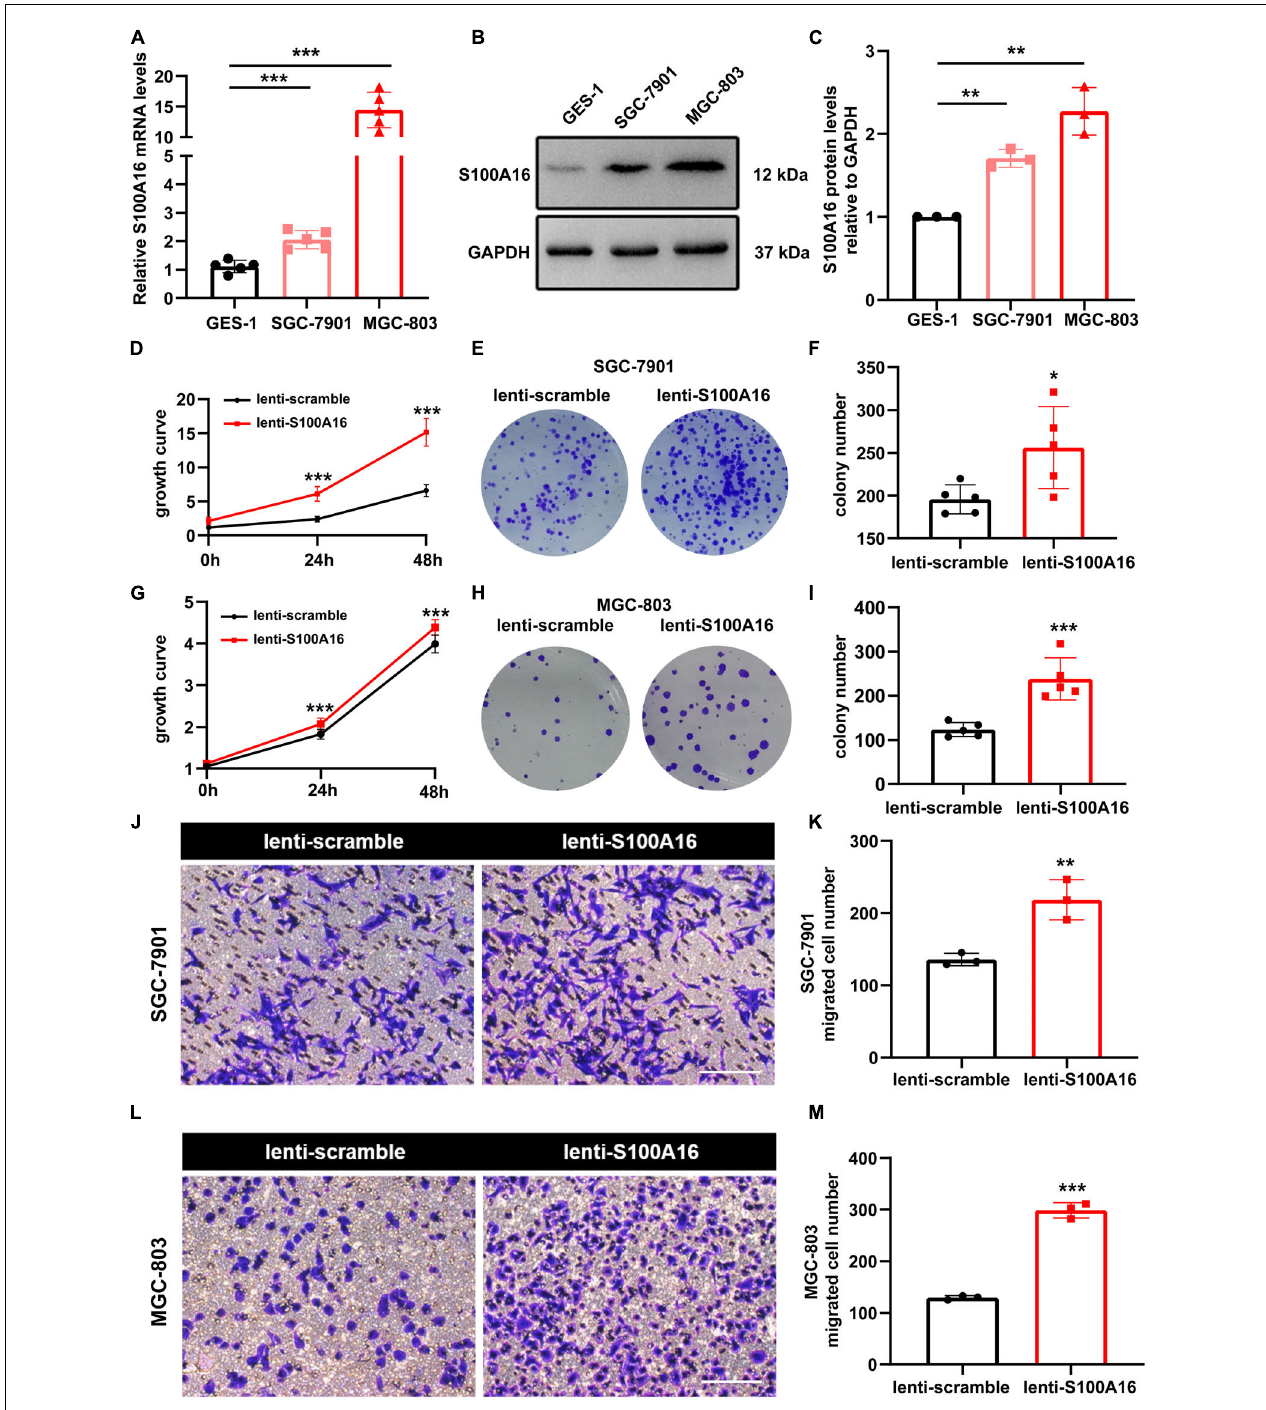
FIGURE 3 | Overexpression of S100A16 accelerates GC cells growth and migration in vitro . (A,B) The mRNA and protein levels of S100A16 in GES-1, SGC-7901, and MGC-803 cells. GAPDH was used as internal standard. (C) Gray density of panel (B) . (D) Cell growth was measured by SRB staining in SGC-7901 cells stably overexpressing S100A16. (E) Colonies formed by SGC-7901 cells that stably overexpressing S100A16. (F) Colonies number in € were quantified. (G) Cell growth was measured by SRB staining in MGC-803 cells stably overexpressing S100A16. (H) Colonies formed by MGC-803 cells that stably overexpressing S100A16. (I) Colonies number in panel (H) were quantified. (J,K) The migration ability of SGC-7901 cells stably overexpressing S100A16 was measured by transwell assay. Migrated cell numbers were counted in panel (K) . Scare bar = 100 µ m. (L,M) The migration ability of MGC-803 cells stably overexpressing S100A16 was measured by transwell assay. Migrated cell numbers were counted in panel (M) . Scare bar = 100 µ m. Data are presented as mean ± SD. N = 3-15 for each group. For panels (A,C) , * P < 0.05, ** P < 0.01, and *** P < 0.001 vs. GES-1 cells. For panels (D , F , G , I , K , M) , * P < 0.05, ** P < 0.01, and *** P < 0.001 vs. lenti-scramble group.